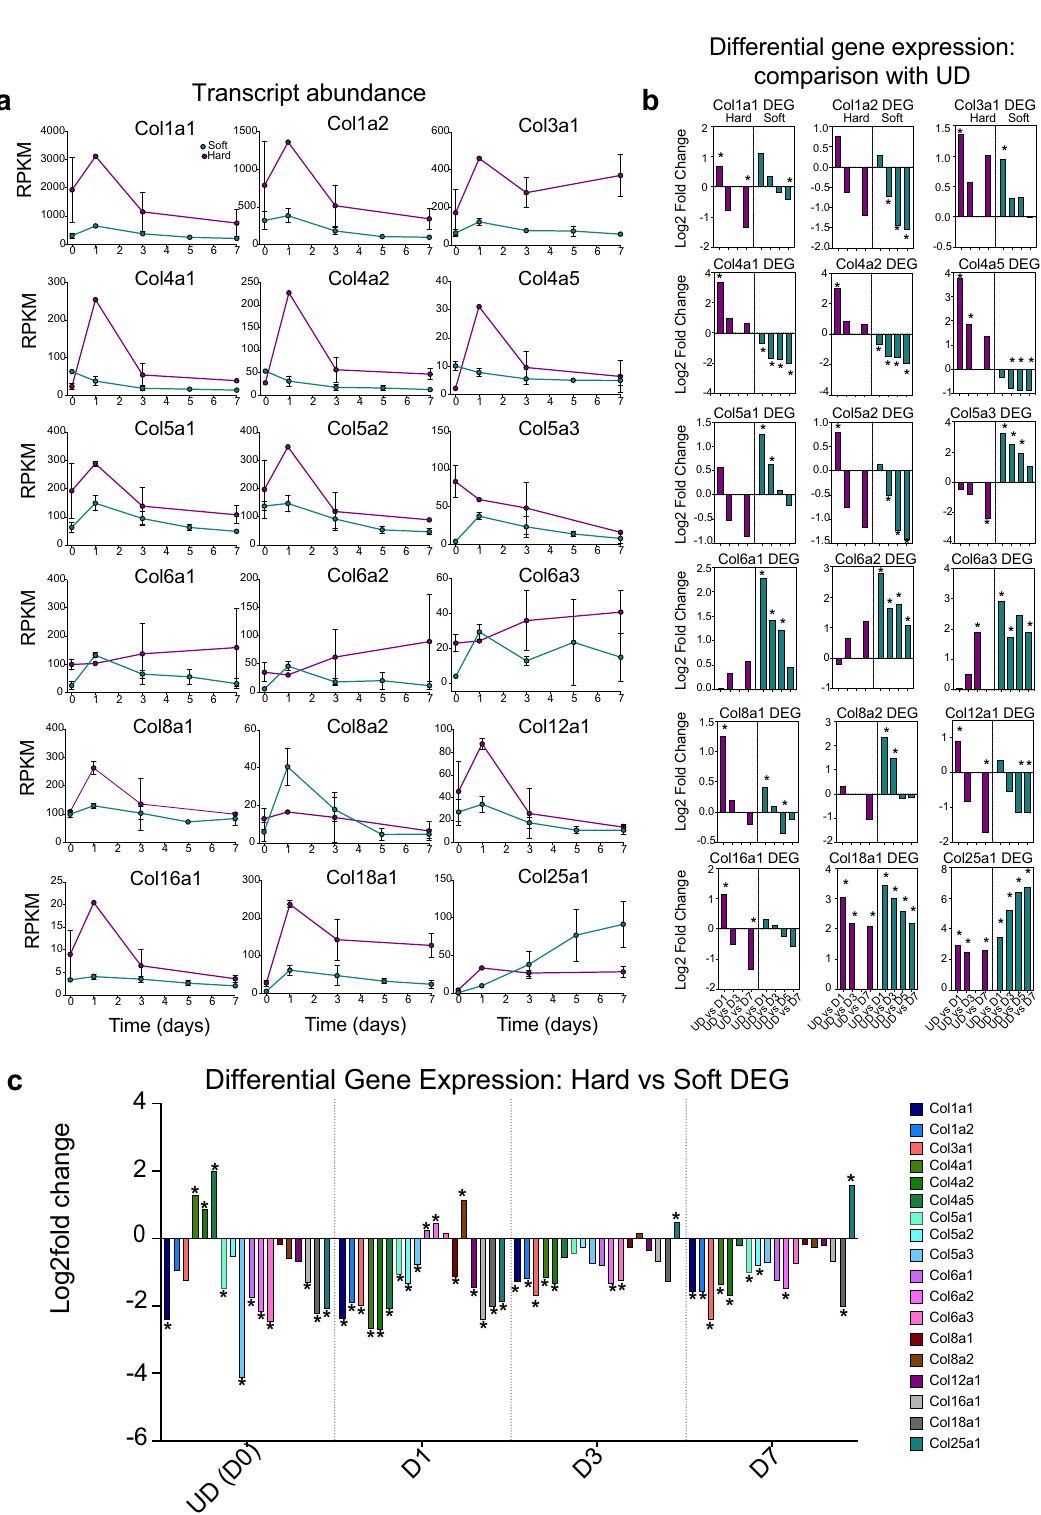
Figure 7. Expression of collagen genes on hard or soft surfaces in C1F cells. ( a ) RPKM plots for hard (magenta) and soft (green) surfaces for genes of interest, over time. Day 0 (D0) represents undifferentiated cells (UD). Days 1–7 represent the time course of differentiation. Error bars show the standard deviation (S.D.). ( b ) DEG that compares expression for each gene over time, comparing UD with F1 etc. for cells cultured on hard and on soft surfaces. *Indicates significant change in log 2 fold expression (p adj value < 0.05). ( c ) DEG comparing expression of each gene for cells cultured on hard versus soft surfaces, at each time point. *Indicates significant change in log 2 fold expression (p adj value <